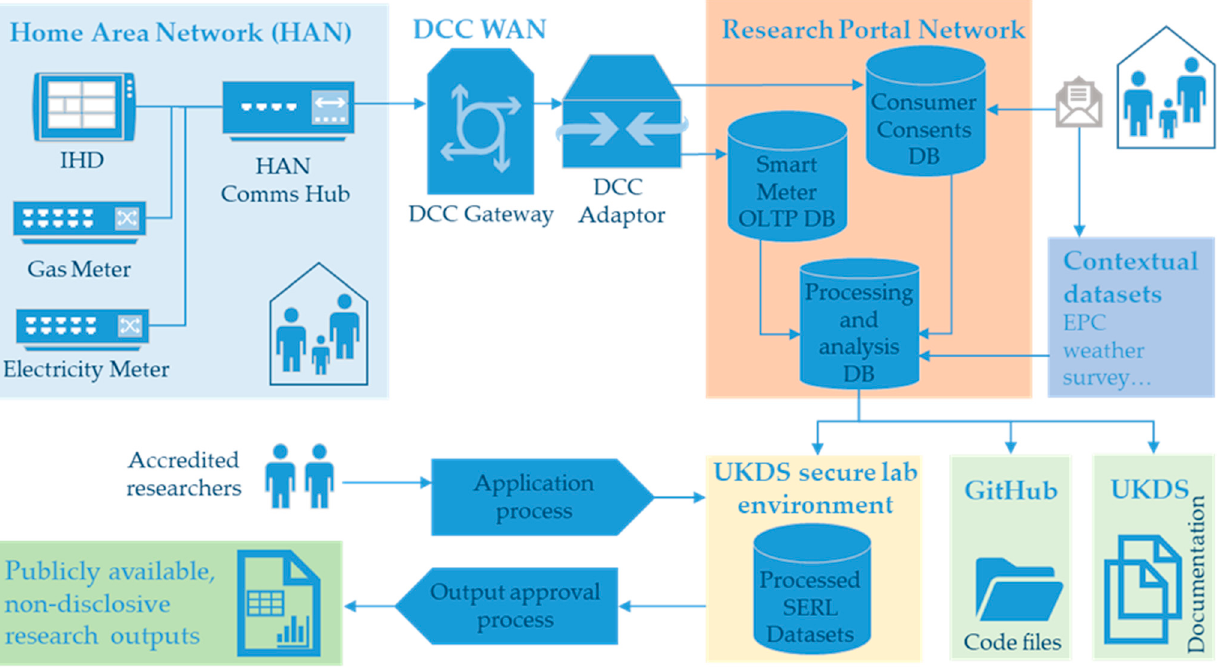
Figure 2 . SERL system diagram summarising the data flows and access processes for SERL Observatory data.